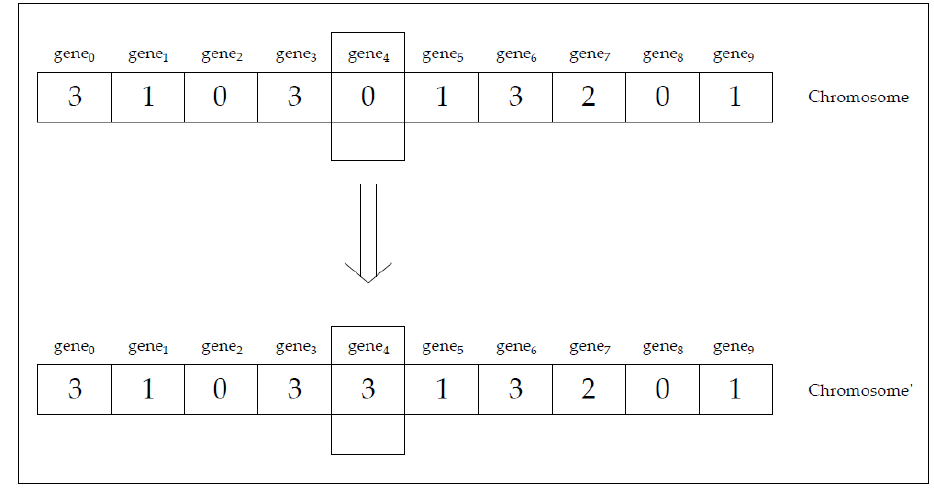
Figure 11. The mutation process example.